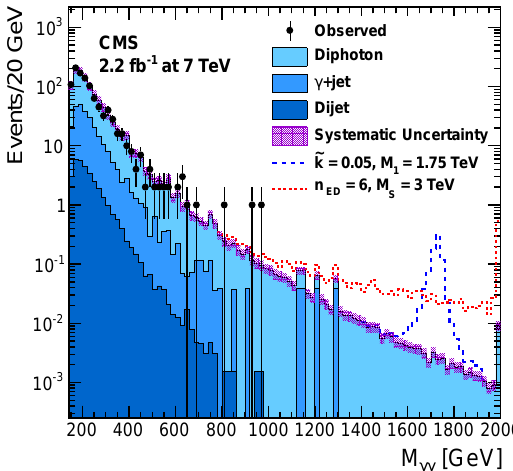
Fig. 1. Diphoton invariant mass spectrum. Observed event yields (points with error bars) and background expectations (filled solid histograms) as a function of the diphoton invariant mass. The shaded band around the background estimation corresponds to the average systematic uncertainty over the spectrum. The last bin includes the sum of all contributions for M γγ > 2 . 0 TeV. The simulated distributions for two signal hypotheses are shown for comparison as dotted (ADD) and dashed (RS)